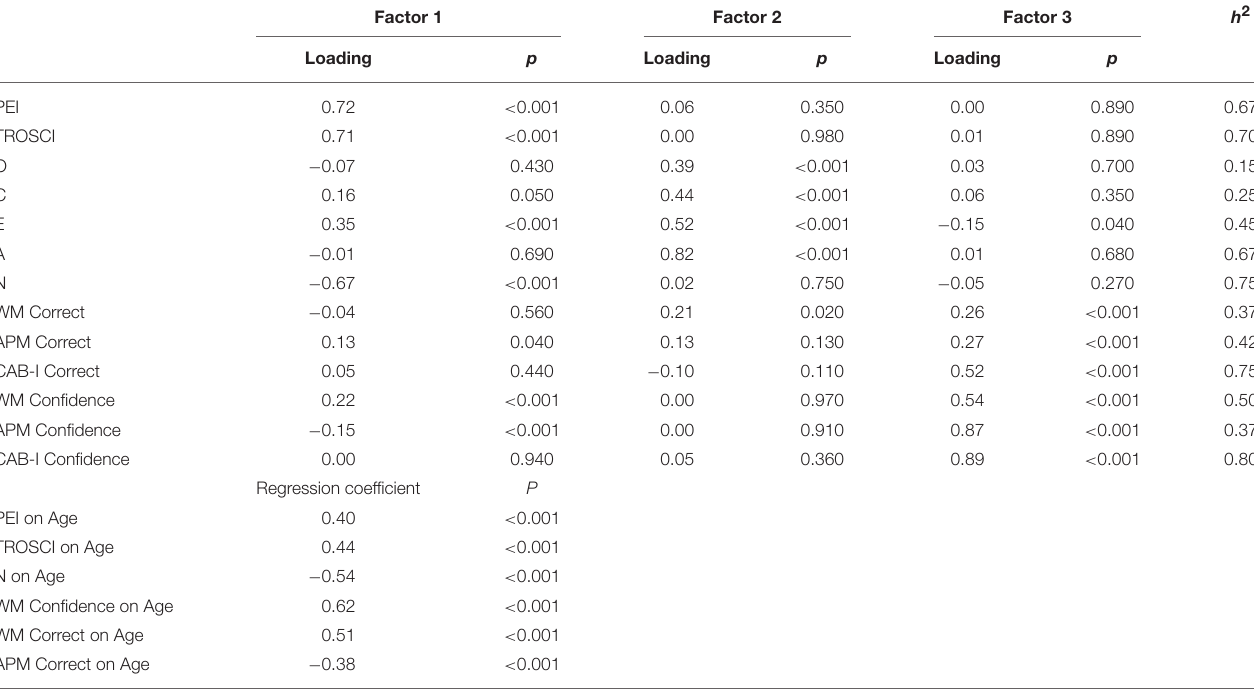
TABLE 5 | Results of three-factor exploratory structural equation model for five self-confidence measures, five personality measures, and three ability measures ( N =